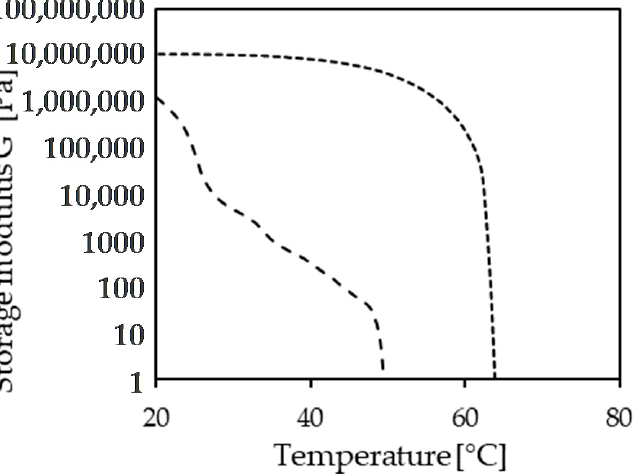
Figure 4. Storage modulus on cooling temperature sweep, 12% structurant in canola oil, short dashed: bees wax hydrolyzate, long dashed sunflower wax. Cooling at 5 K/min at constant strain 0.1% and angular frequency of 10 rad/s (plate/plate geometry, MCR 302, Anton Paar) [67]. Beeswax hydrolyzate (short dashed) shows a stepwise crystallization since it is a complex mixture containing fatty acids, fatty alcohols, and wax esters, all of varying carbon chain length. In contrast, the sunflower wax data (>95% wax esters, long-dashed line) indicate the co-crystallization to a single solid phase. This observation is in line with the data shown in Figure